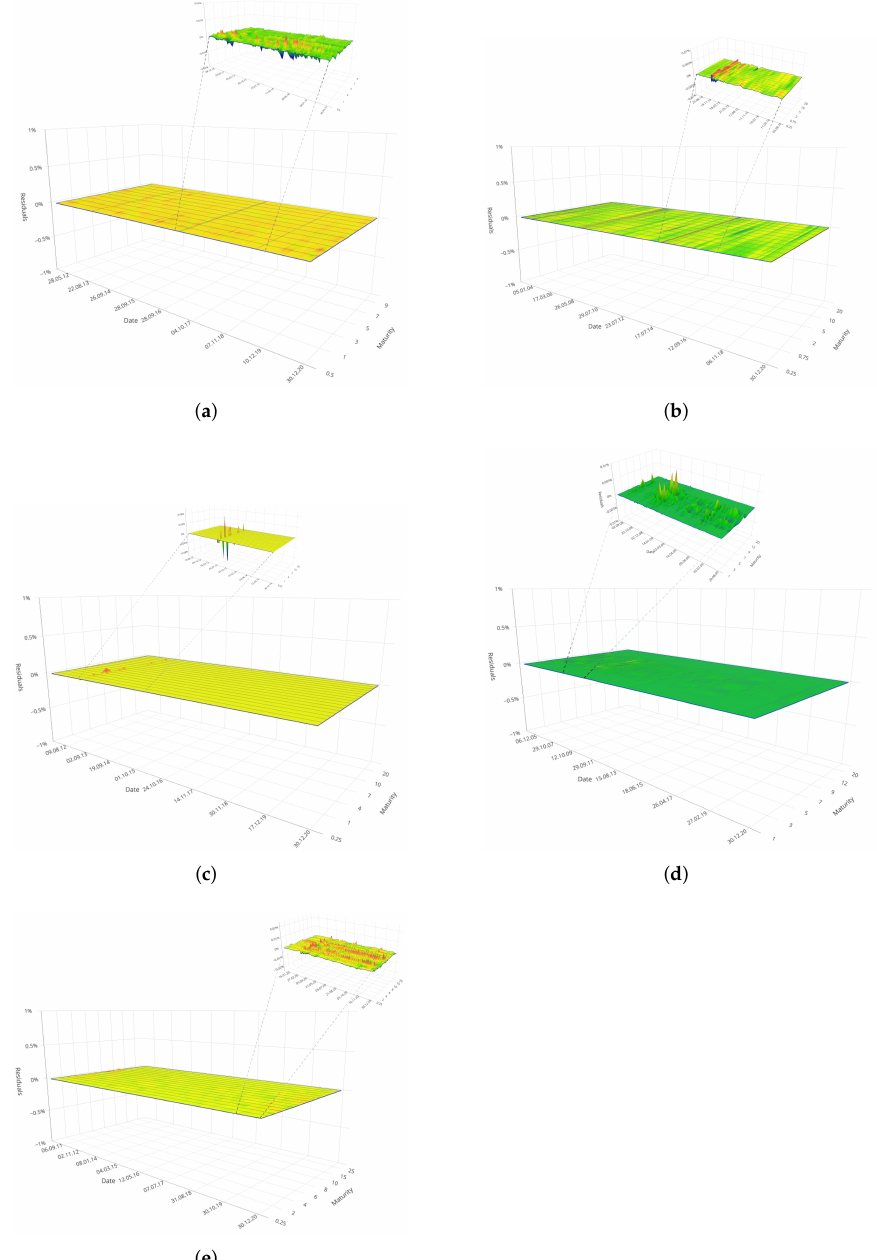
Figure 8. Surface of daily residuals for the yield curve obtained with the FFNN in the BRICS bond market. As the error surface is very flat, the inset shows a zoomed–in area highlighting the error fluctuations otherwise not visible at the same scale employed to visualize the error surface of the 5F–DRF. From top to bottom and from left to right, ( a ) is associated to Brazil, ( b ) to Russia, ( c ) to India, ( d ) to China, ( e ) to South